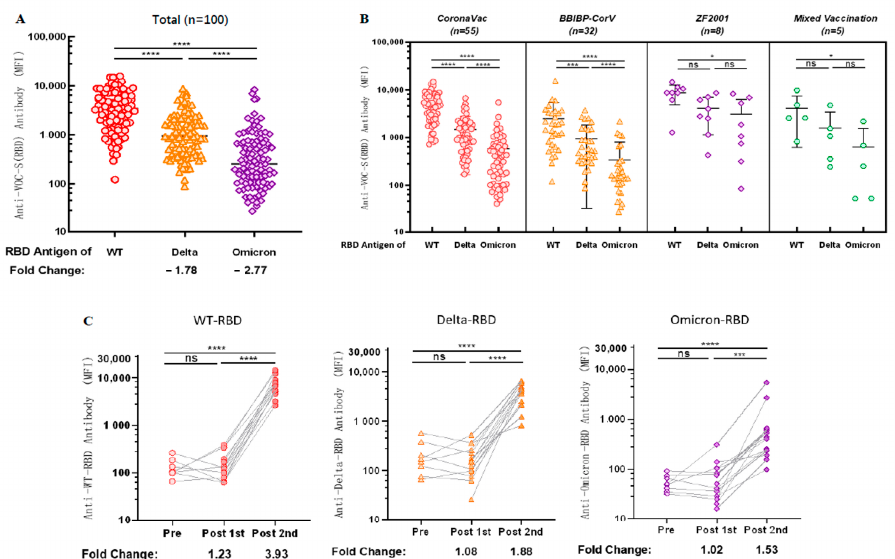
Figure 4. Antibodies induced by vaccination show cross-reactivity with the RBD antigen of VOCs. ( A ) Cross-reactivity of antibodies in sera to RBD antigens of VOCs after vaccination. ( B ) Cross-reactivity of IgG against RBD antigen of VOCs in sera was induced after different types of vaccination. ( A , B ) MFI values were logged and then compared two-by-two for multiple samples means using the LSD (Least-Significant Difference) test. ( C ) Dynamic changes of IgG cross-reactivity with RBD antigen of VOCs in serum samples from a cohort vaccinated with CoronaVac. MFI values were logged and analyzed for statistical significance using paired t-test. * p < 0.05, *** p < 0.001, and **** p < 0.0001.